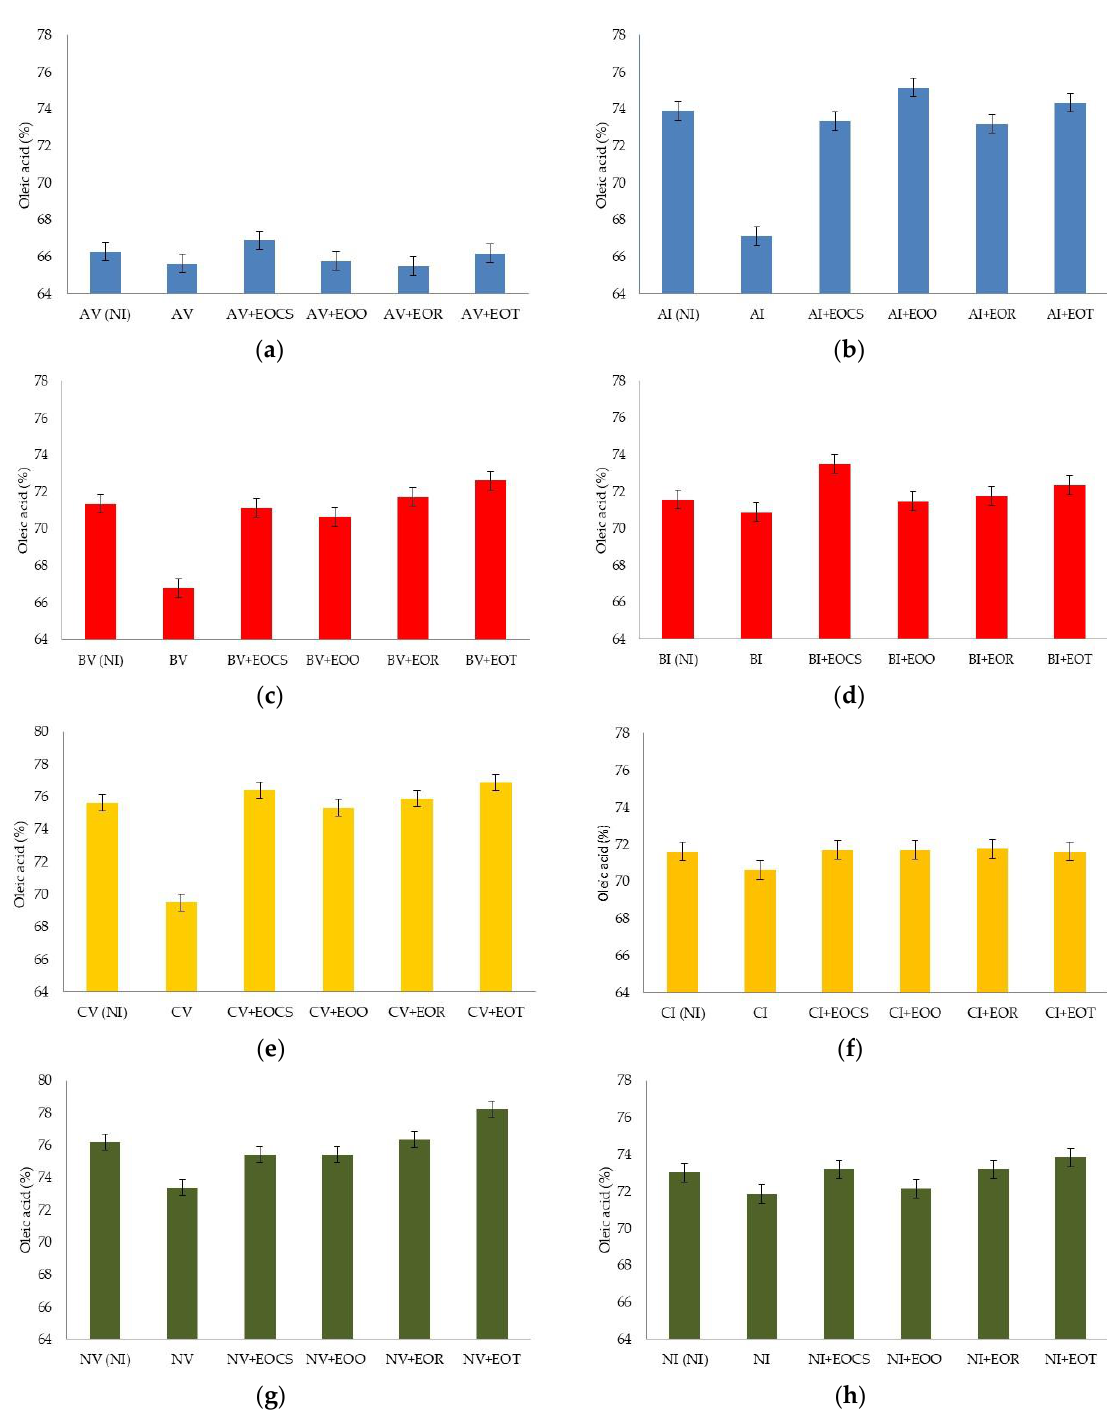
Figure 4. Percentage content of oleic acid in the extra-virgin olive oil (EVOO) samples not irradiated, irradiated and in the mixture of EVOO with EO. Average values ( ± standard error) are shown. The initials NI in brackets in all graphs stand for not irradiated; EOCS stands for essential oil of common sage; EOO stands for essential oil of oregano; EOR stands for essential oil of rosemary; EOT stands for essential oil of thyme. ( a ) refers to Arbequina “green” (AV), ( b ) refers to Arbequina “brown” (AI), ( c ) refers to Biancolilla “green” (BV), ( d ) refers to Biancolilla “brown” (BI), ( e ) refers to Cerasuola “green” (CV), ( f ) refers to Cerasuola “brown” (CI), ( g ) refers to Nocellara del Belice “green” (NV) and ( h ) refers to Nocellara del Belice “brown” (NI).